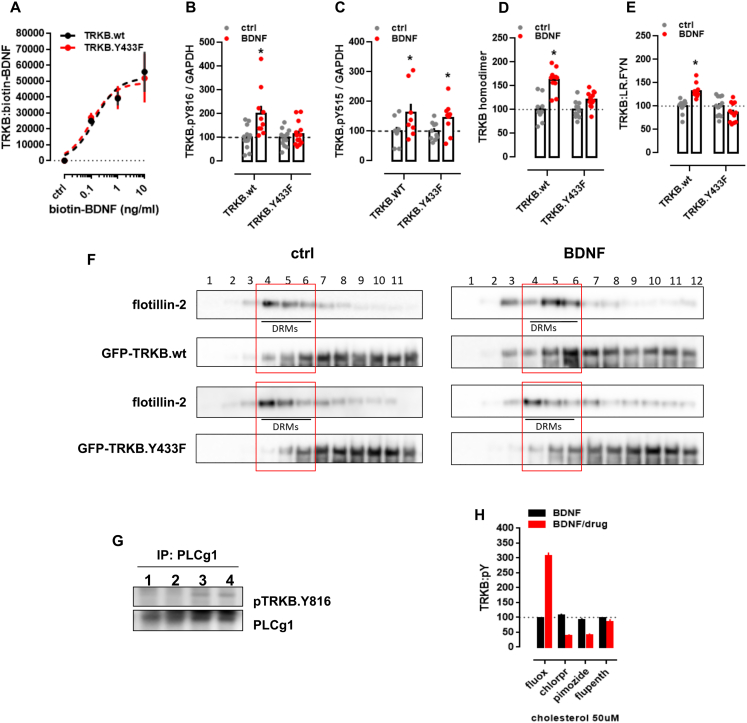
Antidepressants bind to TRKB transmembrane domain, related to Figure 2(A) Lysates from HEK293T cells transfected to express TRKB were submitted to ligand binding assay. BDNF interaction with TRKB is not altered by the Y433F mutation (n = 6/group). See schematics in S5A. (B,C) MG87 cells transfected to express TRKB were treated with BDNF and the levels of pTRKB determined by western-blotting. BDNF-induced phosphorylation of TRKB at (B) Y816 is prevented in the TRKB.Y433F mutant [interaction: F(1,47) = 6.688, p = 0.0129; n = 10-14], but the Y433F mutation does not affect BDNF-induced phosphorylation of TRKB at (C) Y515 residues in MG87 cells [interaction: F(1,33) = 0.1874, p = 0.6679; n = 9-10]. (D,E) N2A cells transfected to express luciferase-tagged TRKB and/or raft-restricted FYN, were treated with BDNF and submitted to PCA. (D) The BDNF-induced dimerization of TRKB is compromised by the Y433F mutation [interaction: F(1,42) = 11.08, p = 0.0018; n = 11-12]. (E) The BDNF-induced increase in TRKB interaction with FYN fragment in lipid raft is compromised by the Y433F mutation [interaction: F(1,44) = 20.96, p < 0.000; n = 12]. Data expressed as mean ± SEM of percentage from ctrl group. ∗p < 0.05 from the control group (Fisher’s LSD). (F) N2A cells transfected to express TRKB were treated with BDNF and submitted to fractionation of membrane components. The Y433F mutation prevents BDNF-induced (10ng/ml/15min) translocation of TRKB to lipid-rafts in N2A cells (DRM: detergent-resistant membranes; 1 of 2 replicas). Rat cortical cells were treated with bCDX and fluoxetine, and the levels of surface TRKB determined by ELISA. Rat cortical cells were treated with fluoxetine or ketamine and submitted to immunoprecipitation of PLC-γ1 and western-blotting for TRKB and PLC-γ1. (G) Representative western-blotting of co-immunoprecipitation of PLC-γ1 and TRKB phosphorylated at Y816 in cultured cortical cells of rat embryo (1 of 2 replicas); lane 1: ctrl, 2: ctrl, 3: fluoxetine (10 μM/15min), 4: ketamine (10 μM/15min). (H) Rat cortical cells were preincubated with cholesterol (50uM) and fluoxetine, chlorpromazine, pimozide or flupenthixol (10uM) for 15min and challenged with BDNF (10ng/ml/15min). The levels of TRKB:pY were determined by ELISA [interaction: F(3,64) = 181.9, p < 0.0001, n = 9/group]. Data expressed as mean ± SEM of percentage from ctrl group. ∗p < 0.05 from the control group (Fisher’s LSD).